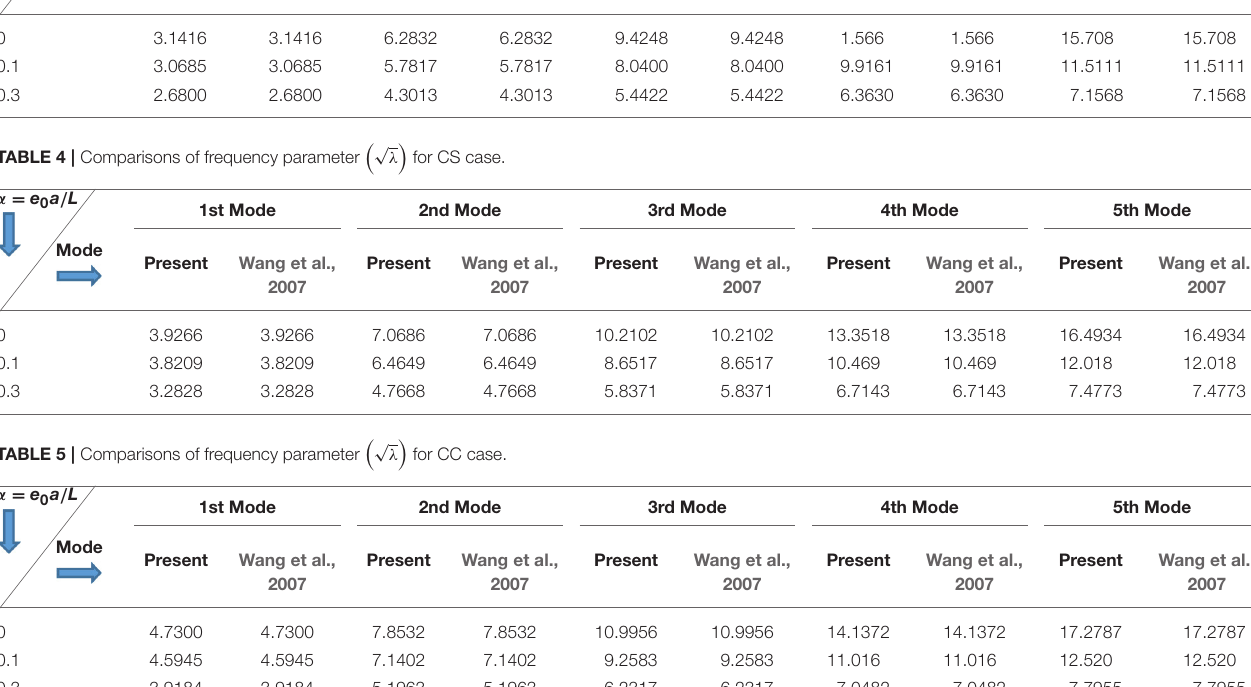
TABLE 3 | Comparisons of frequency parameter α = e 0 a / L Mode